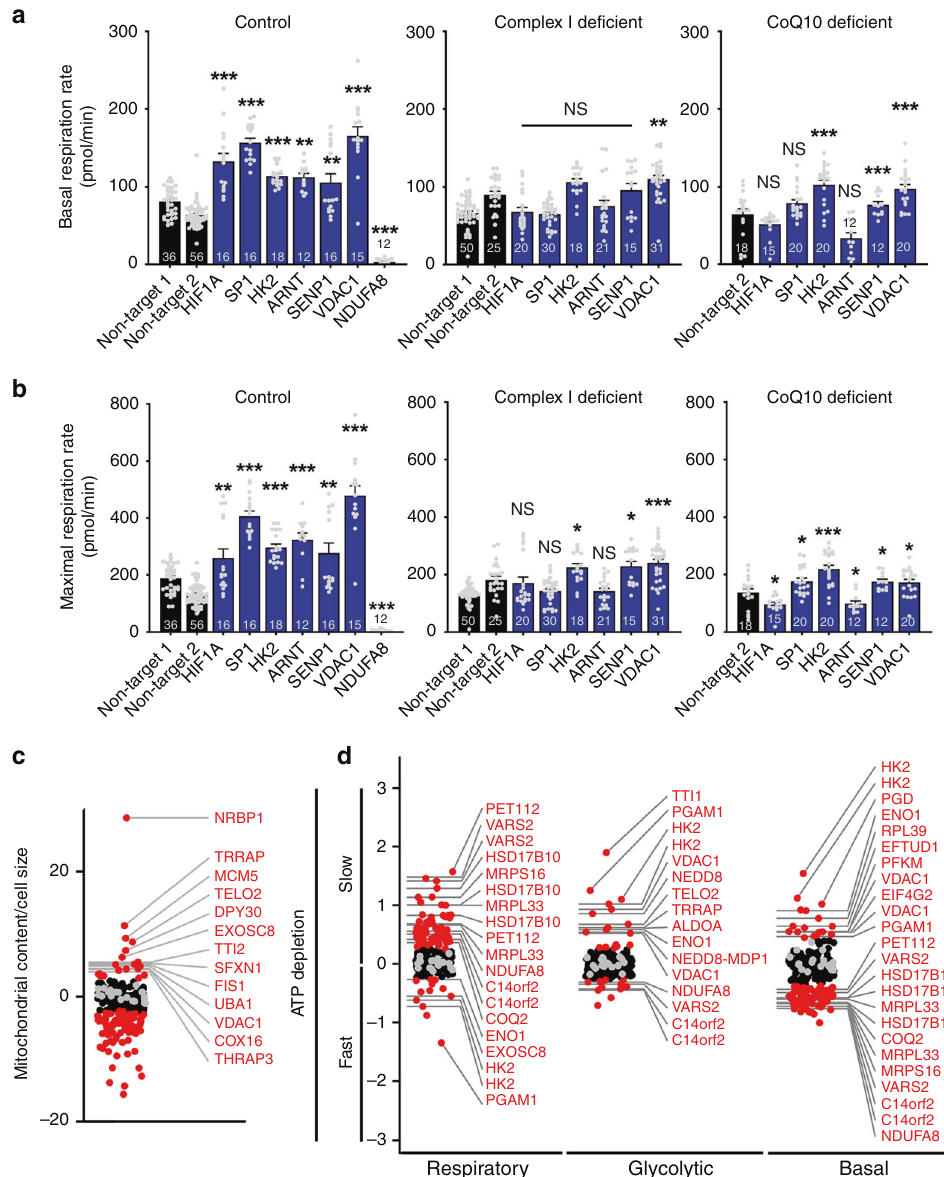
Fig. 4 High ATP hits increase ATP through distinct mechanisms. a , b Subset of high ATP respiratory hits require an intact respiratory chain to boost respiration. Basal ( a ) and maximal respiration (pmol O 2 /min) ( b ) of fi broblast lines from control and respiratory chain de fi cient patients, measured with a Seahorse Analyzer after the addition of the mitochondrial uncoupler FCCP (1 μ M). All data were analyzed from the total number of samples shown in the bars, in at least two experiments per line. Data are presented as mean values± SEM; * p < 0.05, ** p < 0.01, *** p < 0.001, NS not signi fi cant by one-way ANOVA with Dunnett multiple comparisons test. c Subset of ATP respiratory hits increase mitochondrial content. K562 cells expressing the CRISPRi mini- library enriched in ATP respiratory hits. Data show sgRNAs that increased mitochondrial content (MitoTracker Green) normalized to cell size (forward scatter) by FACS. Hits marked by red dots have phenotypes greater than three standard deviations from the mean of nontargeting guides. n = 4 replicates of 500k collected cells. d K562 cells expressing the mini-library of ATP respiratory hits were preincubated for 1 h in either respiratory, glycolytic, or basal conditions. The rate of ATP consumption was then estimated as the rate of ATP phenotype decline relative to nontargeting guides when all ATP production was blocked for 16 min (10 mM 2DG, 1 mM IAA, and 5 μ M oligo). Gene knockdowns that decrease ATP consumption have greater enrichment in high ATP fractions after ATP production is blocked. Hits marked by red dots have phenotypes greater than three standard deviations from the mean of nontargeting guides. n = 2 replicates of 150k cells for each pre- and post-ATP depletion group. Source data and exact p -values are provided as a Source data fi